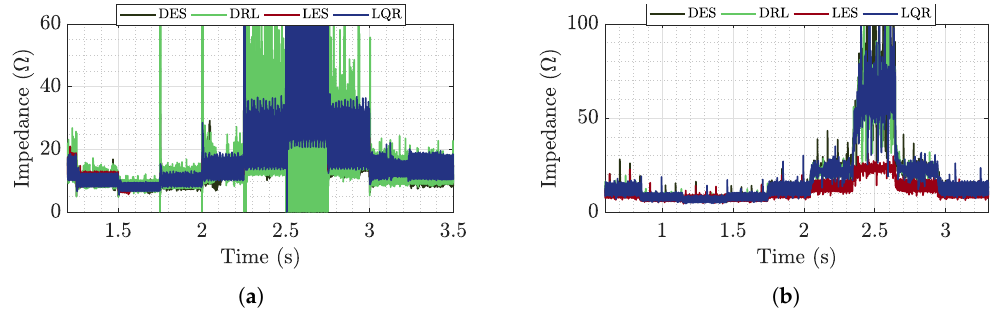
Figure 21. CPL buck input impedance in time during the ( a ) simulation and ( b ) test.